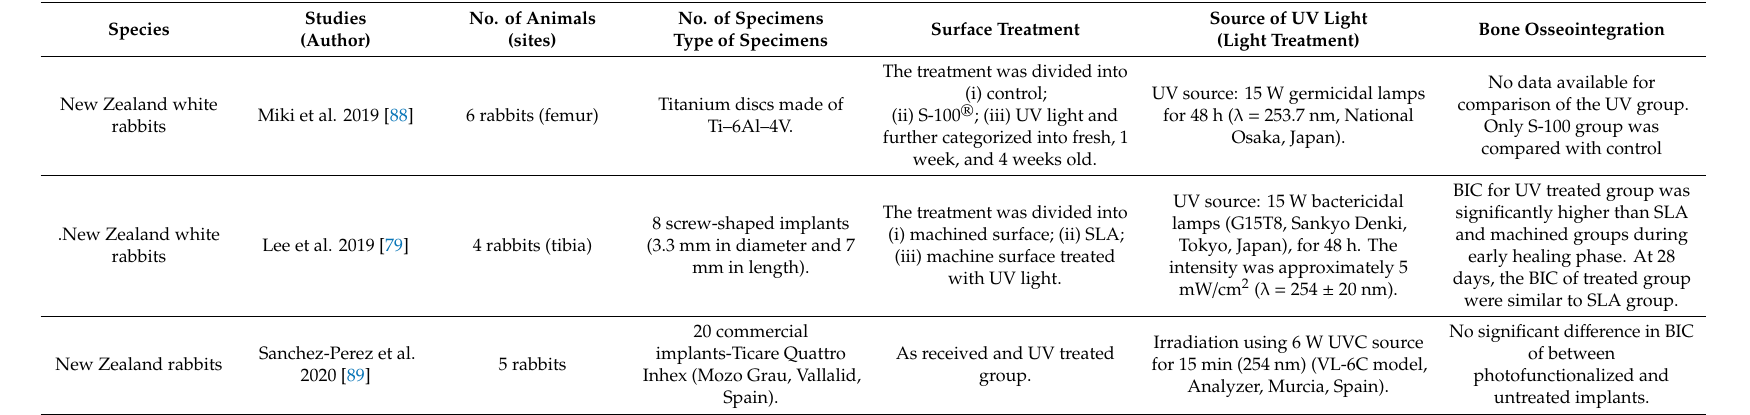
Table 3. E ff ect of UV photofunctionalization on rabbit